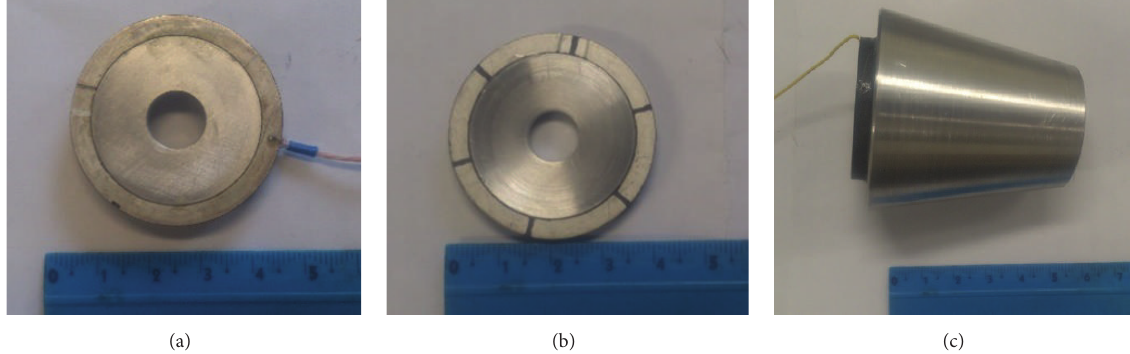
Figure 9: Prototype travelling wave actuators: ring type actuator with asymmetrical waveguide (a), ring type actuator with asymmetrical waveguide (b), and cone type actuator (c).